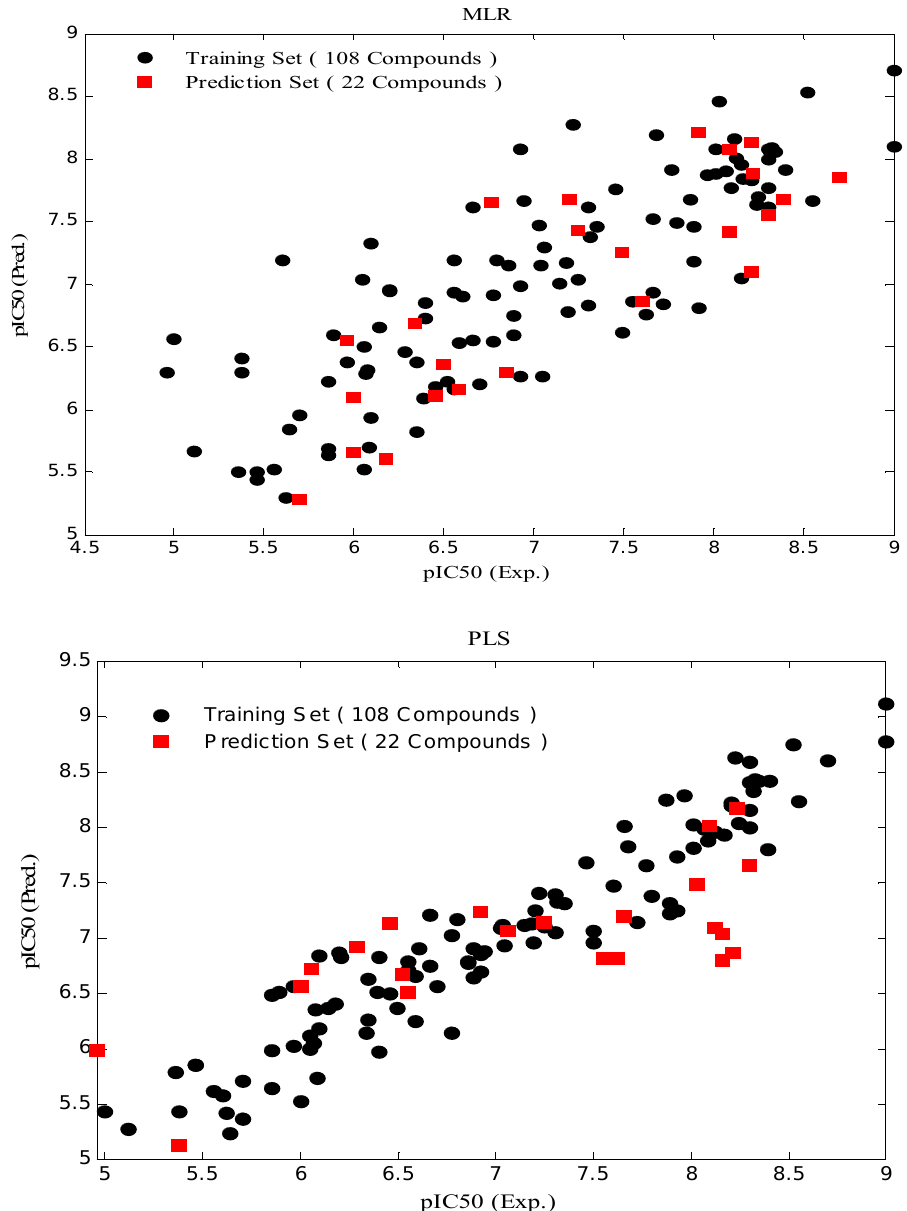
values by (a) MLR; (b) PLS and (c) GA-PLS modeling vs. Figure 4. Predicted pIC 50 experimental pIC 50